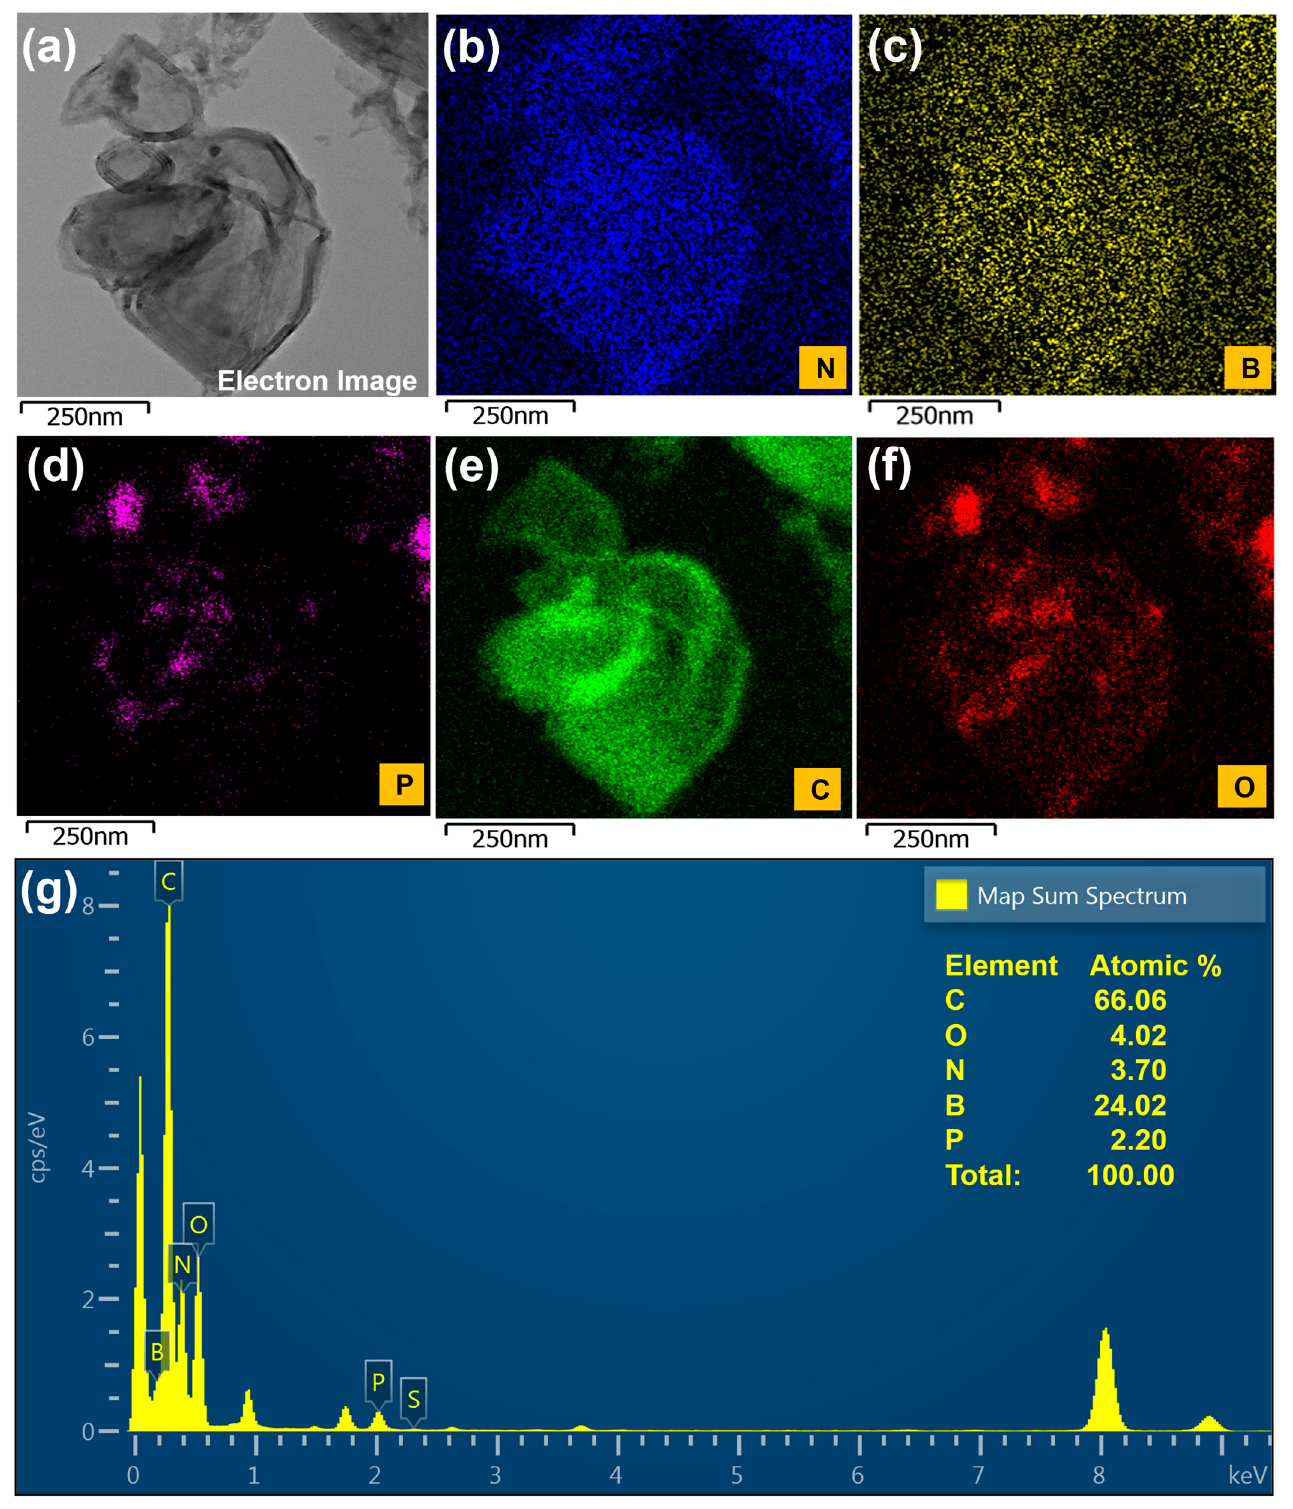
Figure 3. ( a ) STEM image, ( b – f ) element mapping (N, B, P, C, and O elements), and ( g ) EDS results of NBP-PC-Zn sample. NBP-PC-Zn